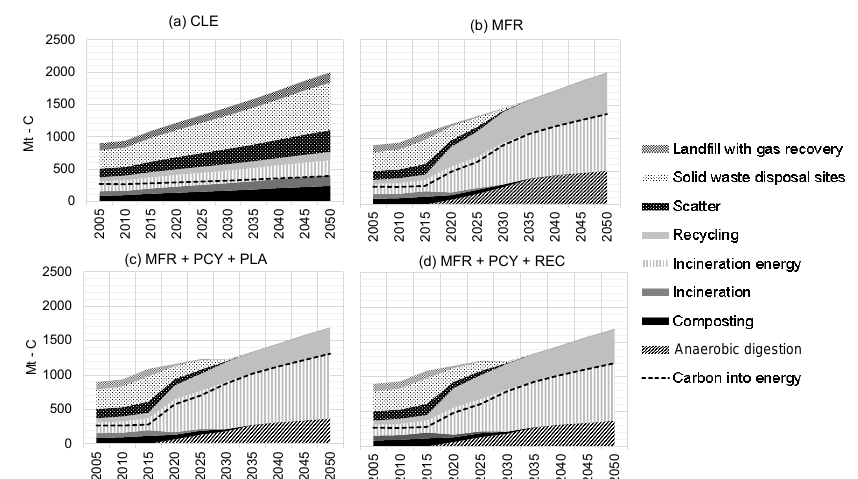
Figure 3. Global carbon content flows in solid waste by scenario.